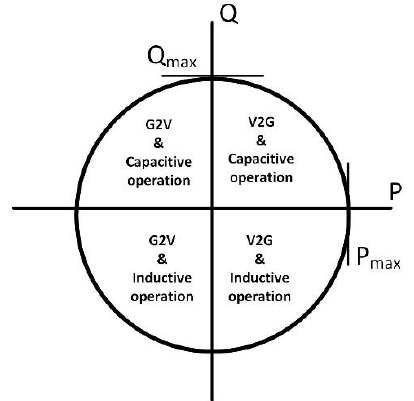
Figure 4. Four-quadrant operation of the DC-AC inverter.